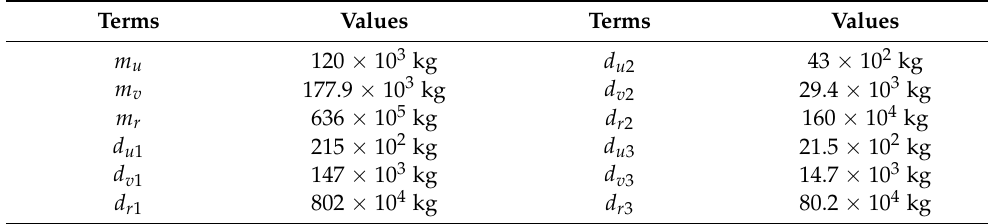
Table 2. Parameter illustration of the considered model